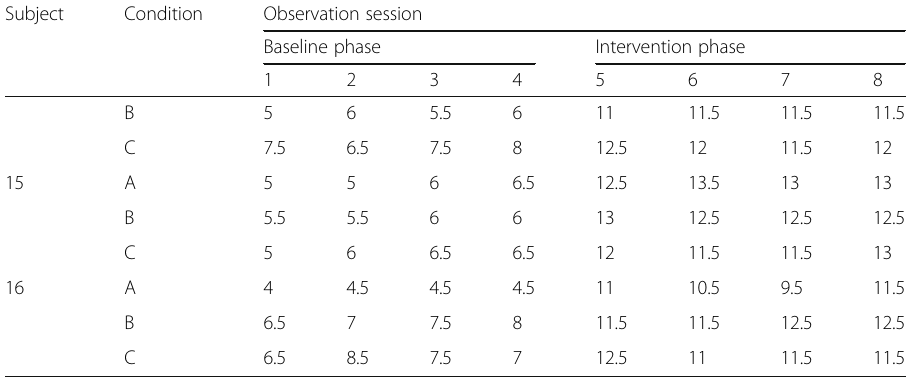
Table 4 The number of acceptable behaviors per observation session and per participant